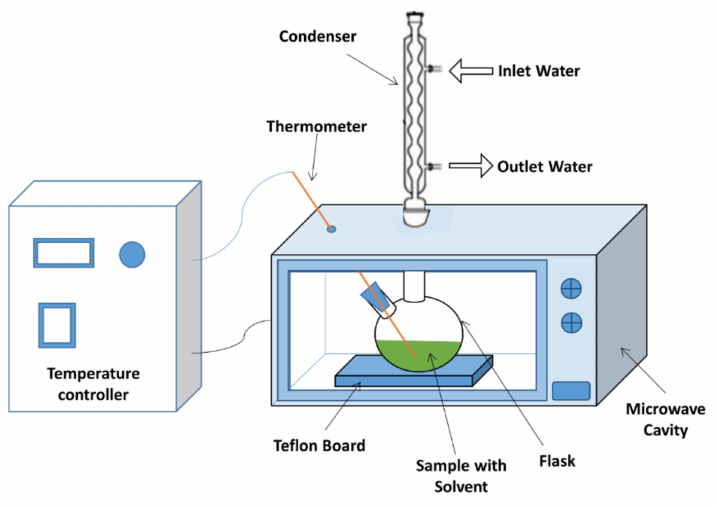
Figure 11. Schematic drawings of the MAE